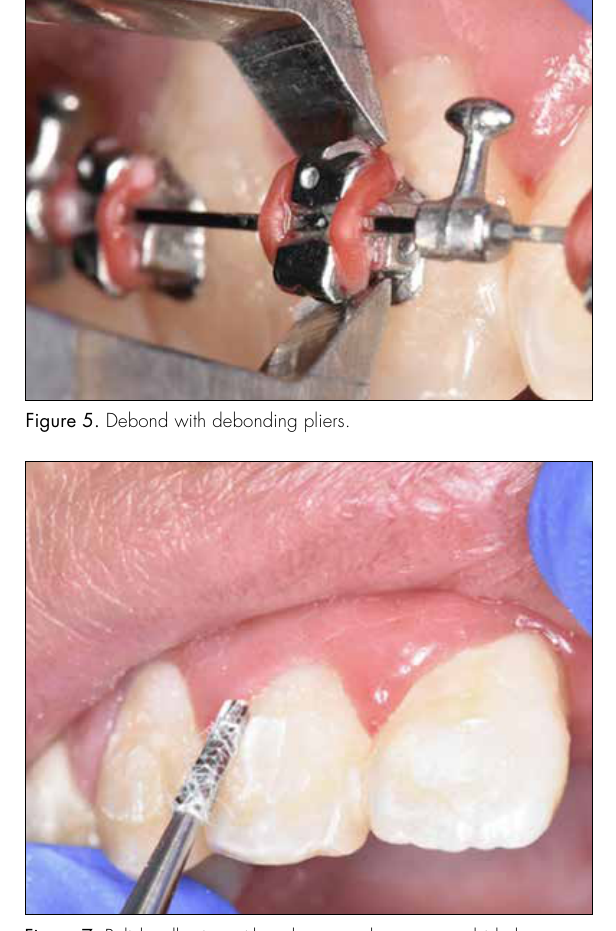
Figure 7. Polish adhesive with a slow speed tungsten carbide bur. Figure 8. Smooth enamel surfaces after polishing with a pumice